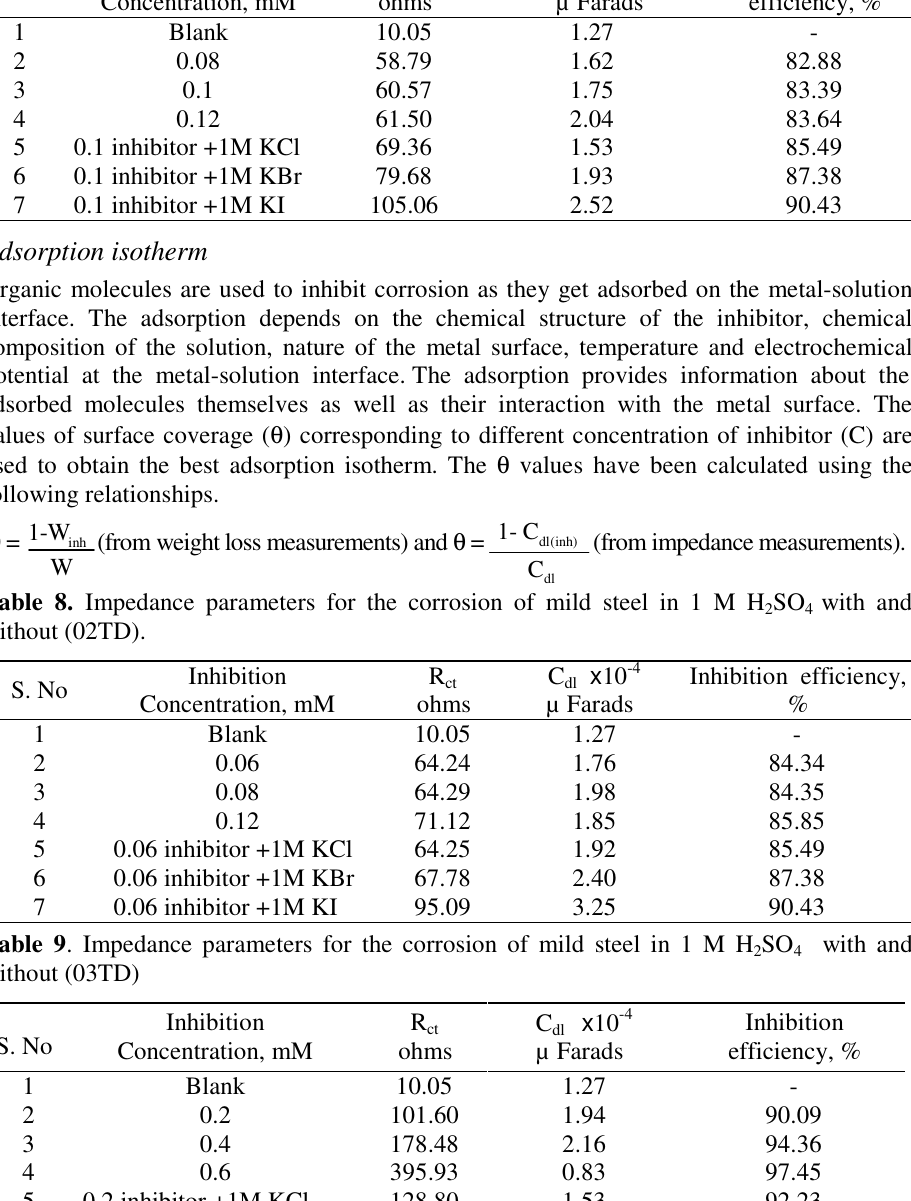
SO with and 2 4